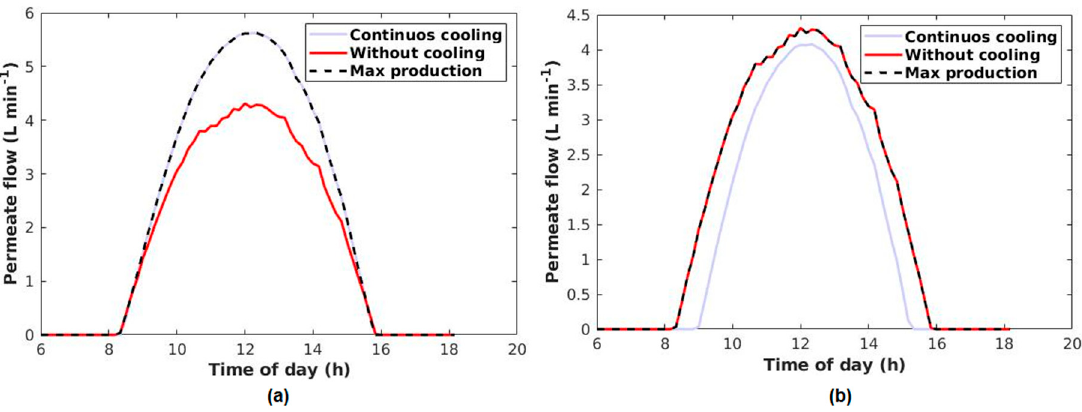
Figure 13. Simulated daily water generation for 20 October 2019, using configuration B1 at: ( a ) Q w = 1 L min − 1 ; ( b ) Q w = 2 L min − 1 .